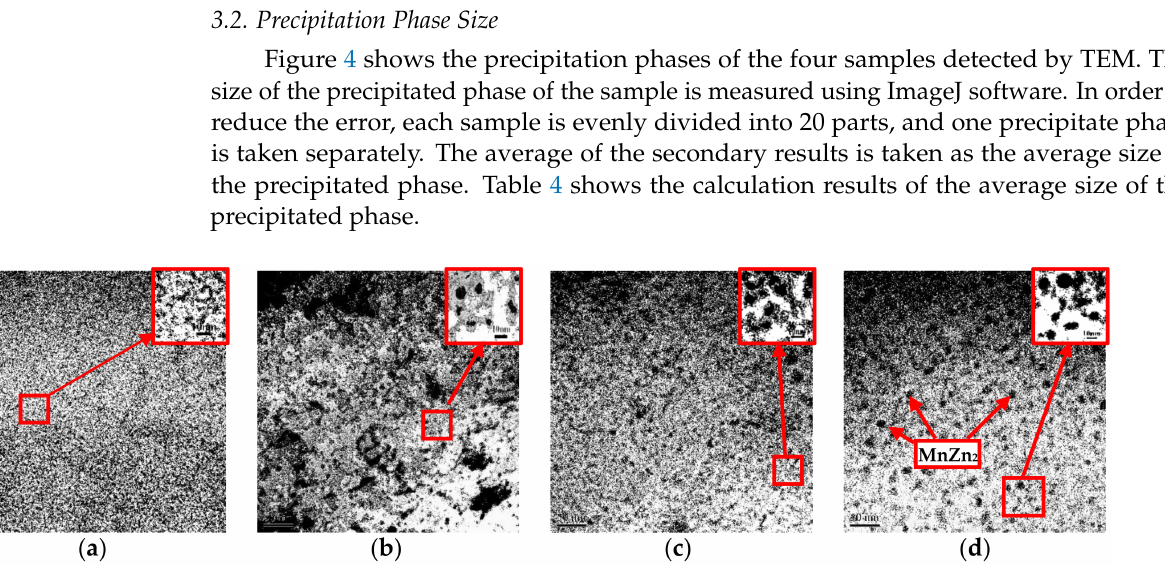
Figure 3. Microstructure measured by SEM: ( a ) 7055-1; ( b ) 7055-2; ( c ) 7055-3; ( d ) 7055-4.